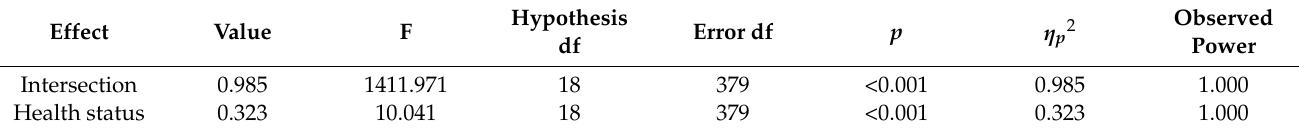
Table 5. Multivariate tests: Pillai